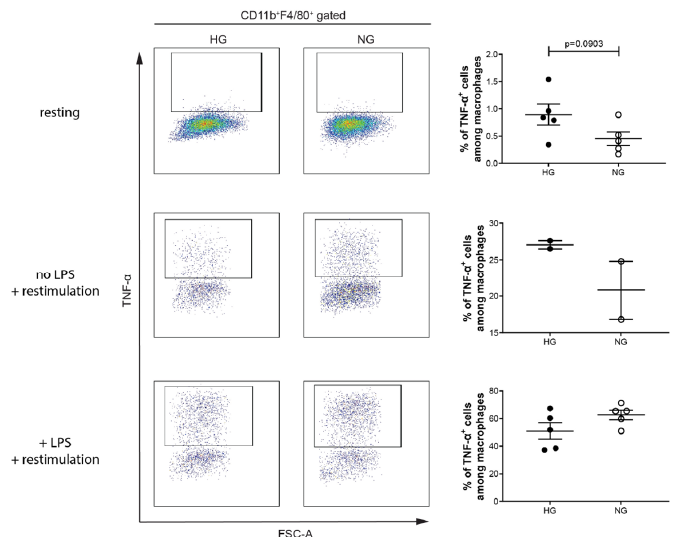
Figure 4. Percentage of M1 macrophage is not altered in diabetic mice. Splenocytes of MLDSTZ induced diabetic mice (HG; high glucose levels) or non-diabetic mice (NG; normal glucose levels) were stained without restimulation (resting), restimulated with or without LPS for 4–5 h, and then stained with antibodies and then the cells were analyzed by flow cytometry. Live cells were gated for CD11b + F4/80 + macrophages and then these cells were further gated for determining the percentages of TNF- α + cells among CD11b + F4/80 + macrophages using FlowJo software. Results are expressed as means ± SEM. Unpaired t -tests were performed for